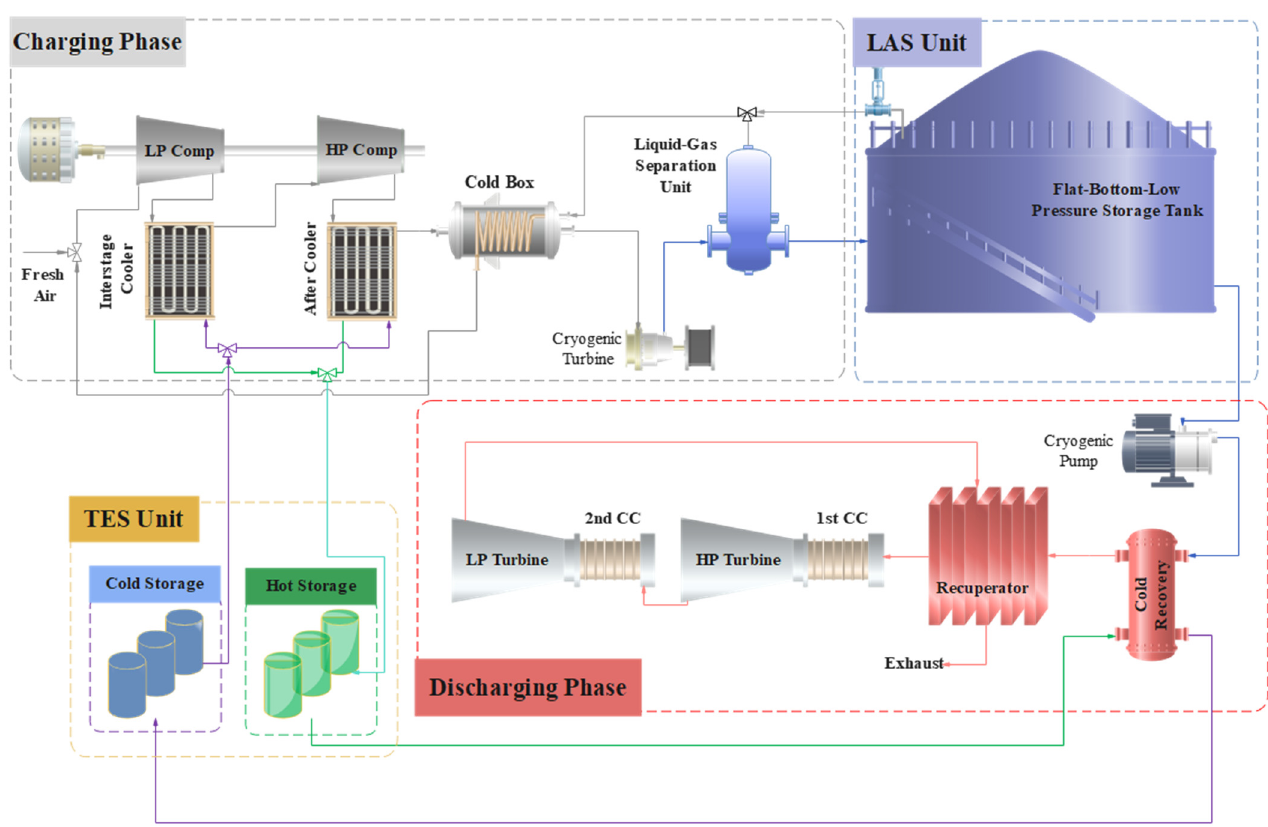
Figure 2. Schematic diagram of an LAES plant integrated with combustion